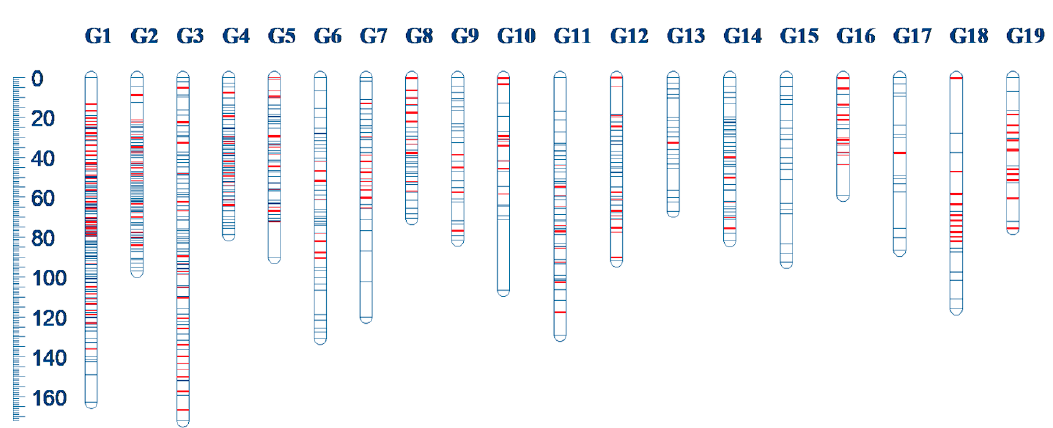
Figure 1. Distribution of 869 segregating markers among 19 linkage groups of Eucommia ulmoides . Red lines represent new SSR markers added on the linkage group. The genetic distance (cM) and linkage group number are shown on the left and top, respectively.